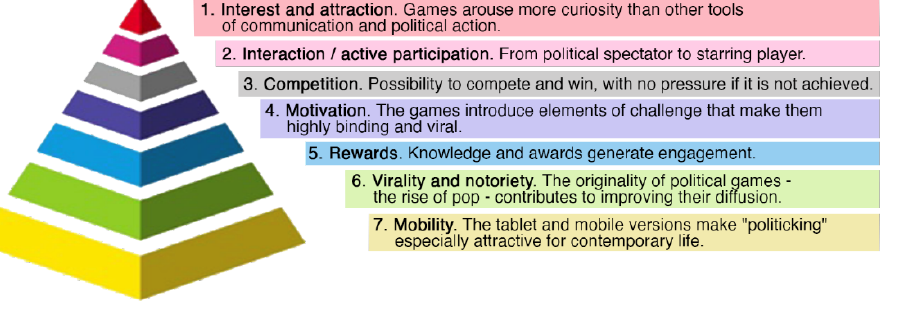
Figure 1. Keys to the success of a casual politicking app. Source: Navarro-Sierra and Quevedo-Redondo (2020) on contributions from Gutiérrez-Rubí (2014, p. 40).